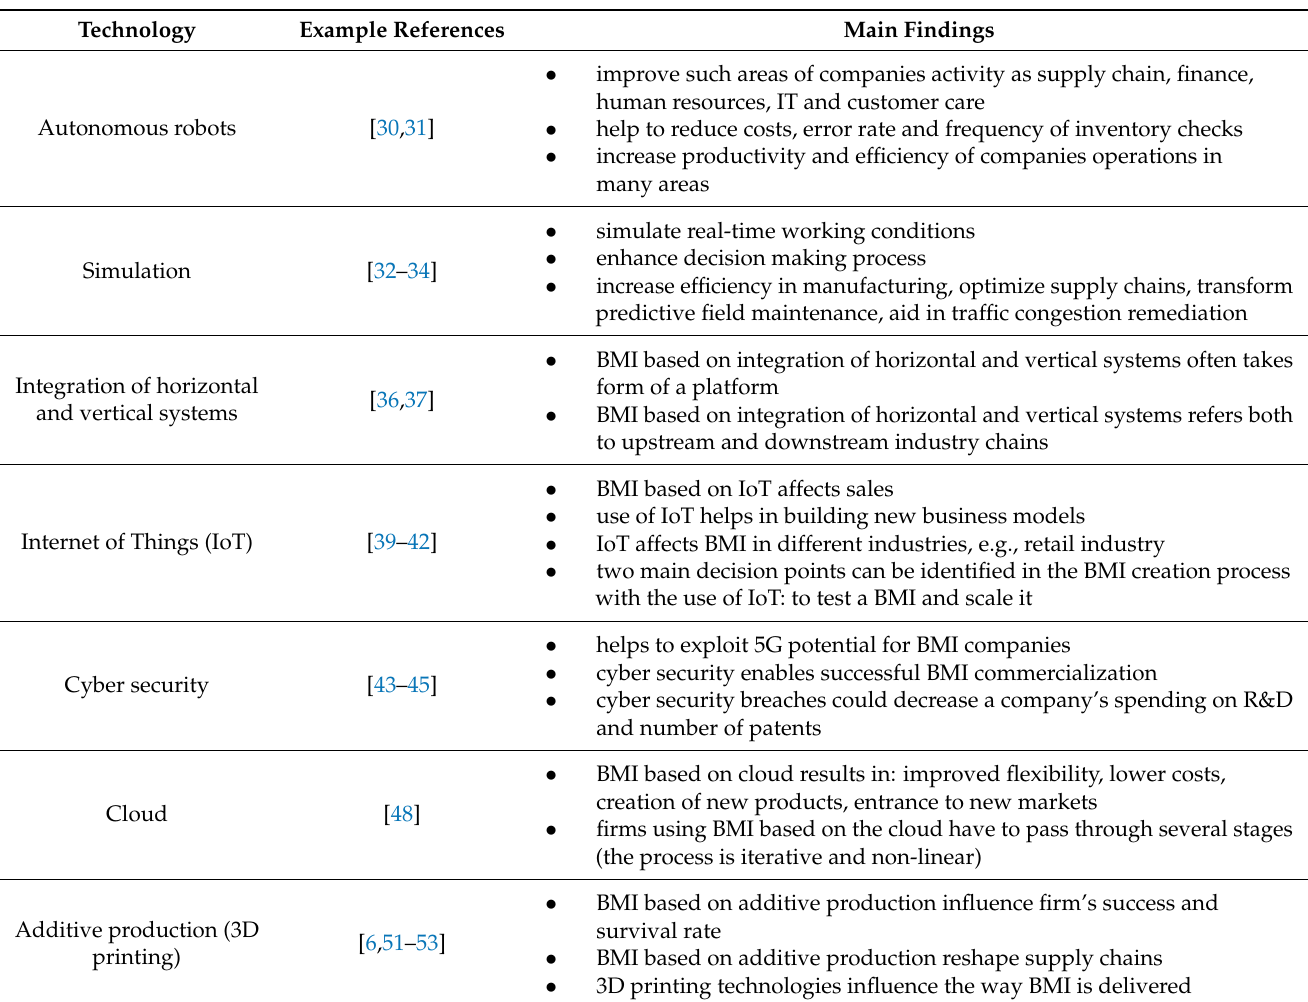
Table 1. Current state of knowledge on BMI based on new technologies and competitive advantage.